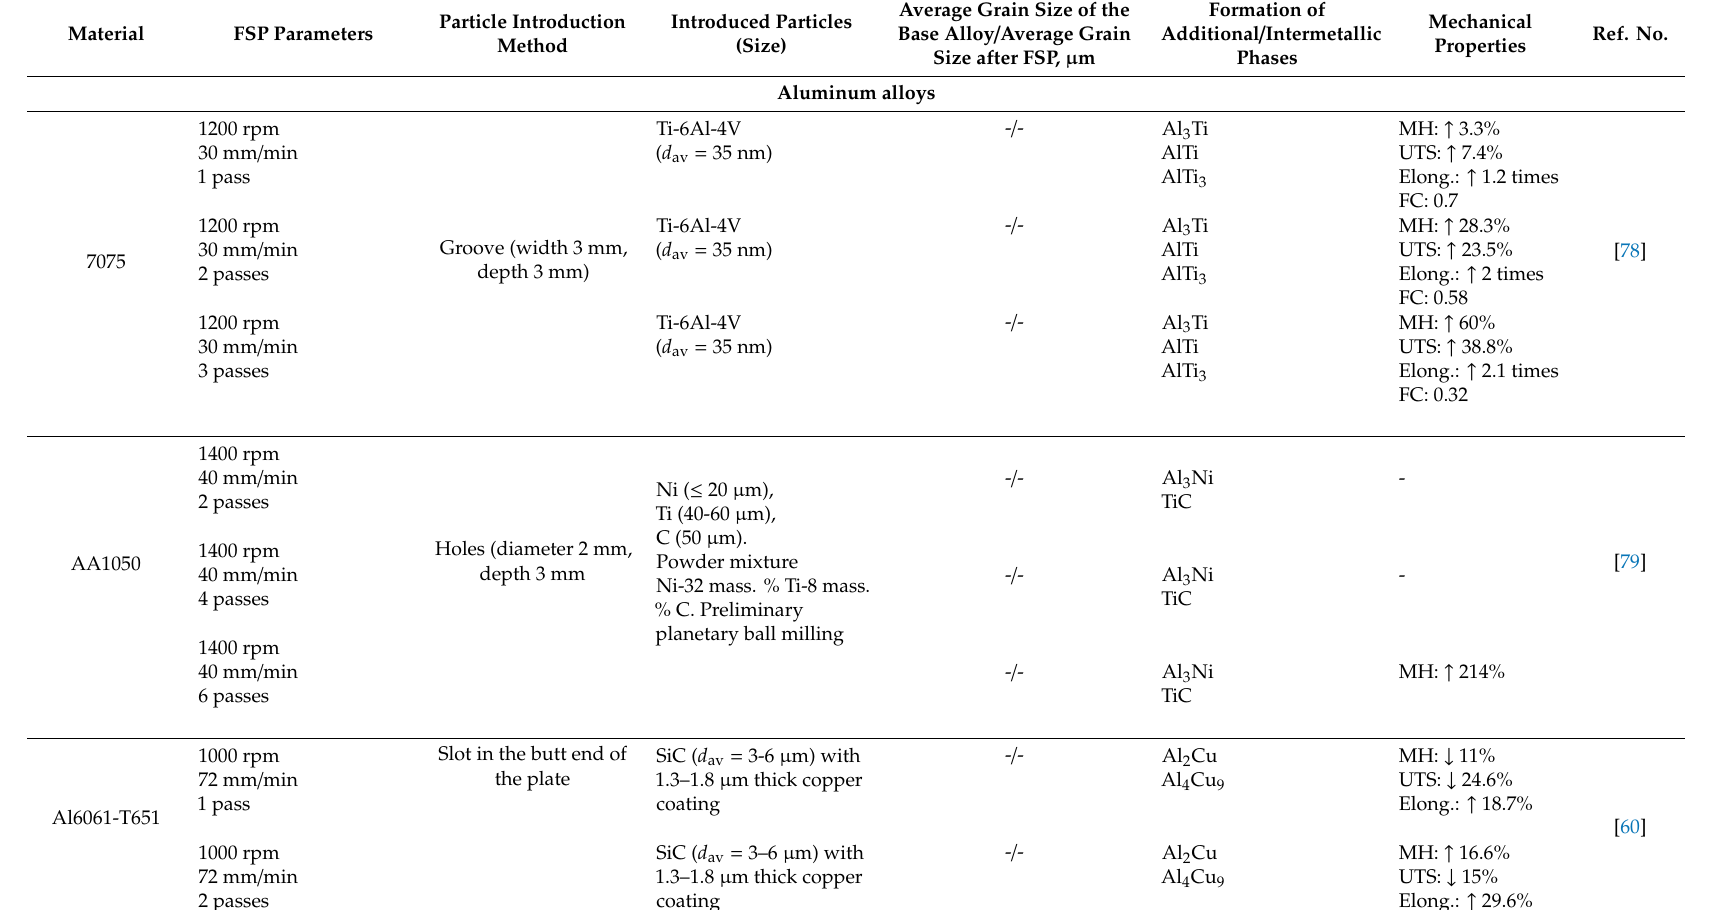
Table 6. Experimental data on FSP of in situ hybrid